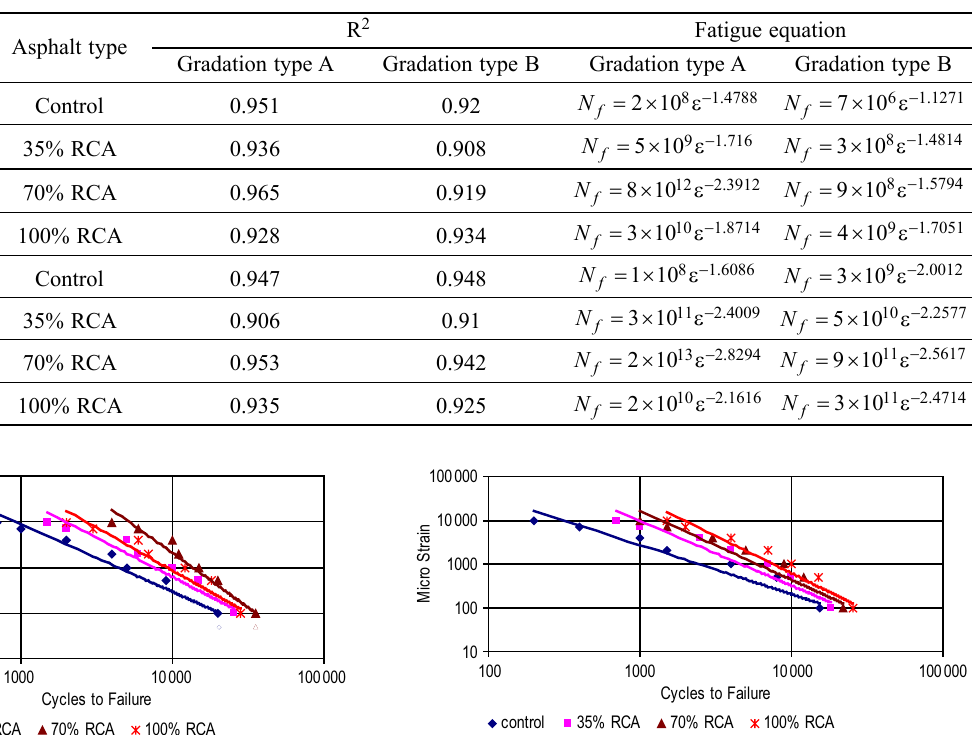
Fig. 4. Comparison of fatigue behavior of different mixes at 5 °C for gradation type A